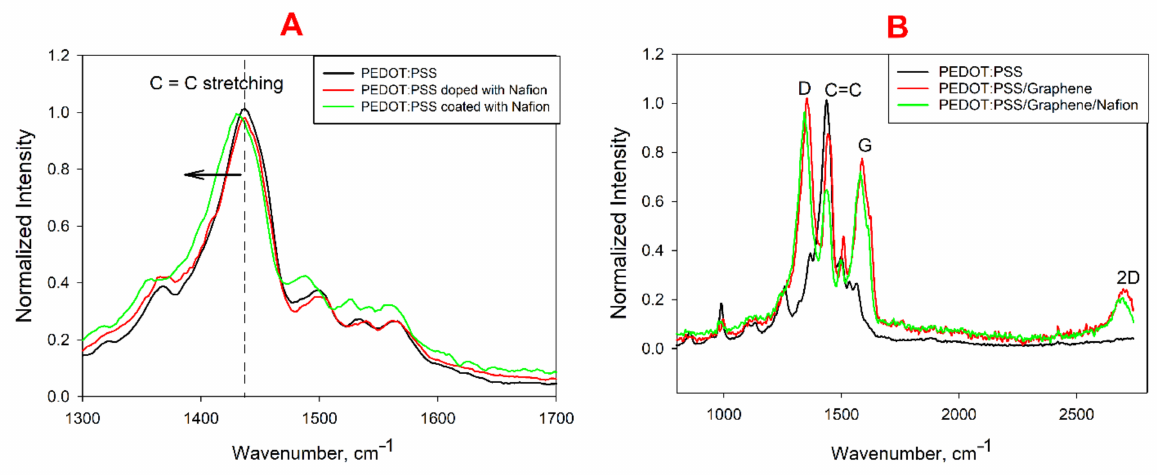
Figure 2. Raman spectra of PEDOT:PSS ( A ) or PEDOT:PSS/graphene ( B ) upon addition of Nafion. Figure 2B shows the spectra of PEDOT:PSS films modified by graphene and